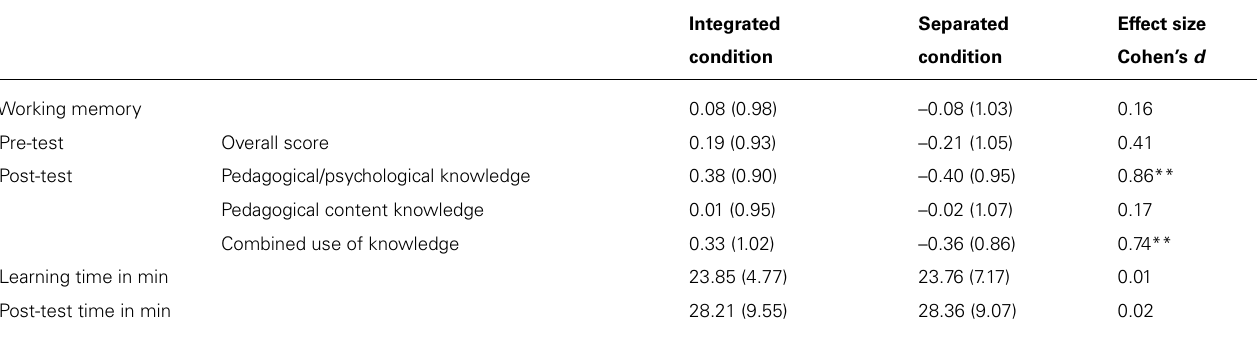
Table 3 | Means (and SD) of important variables in the two experimental